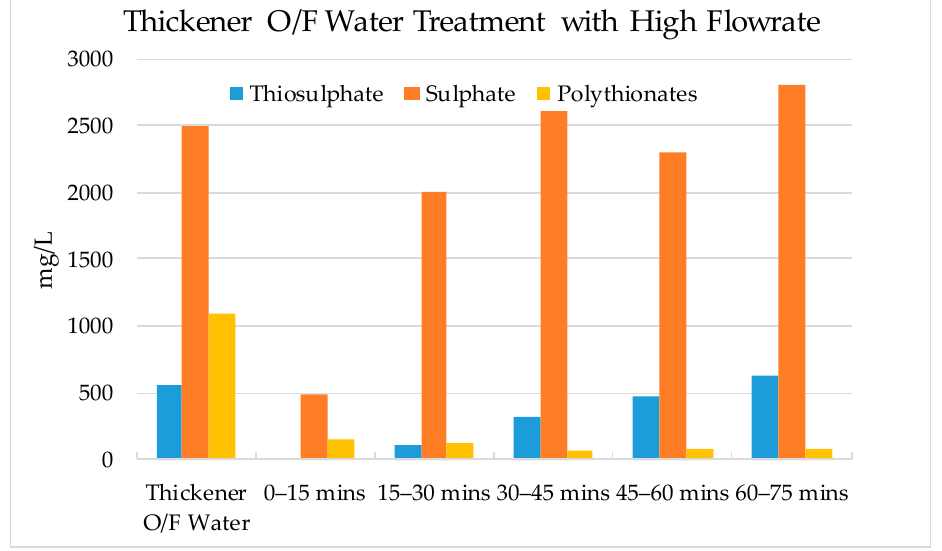
Figure 17. Effect of high water flowrate (60 L/h) on adsorption performance of the resin. Figure 17. E ff ect of high water flowrate (60 L / h) on adsorption performance of the